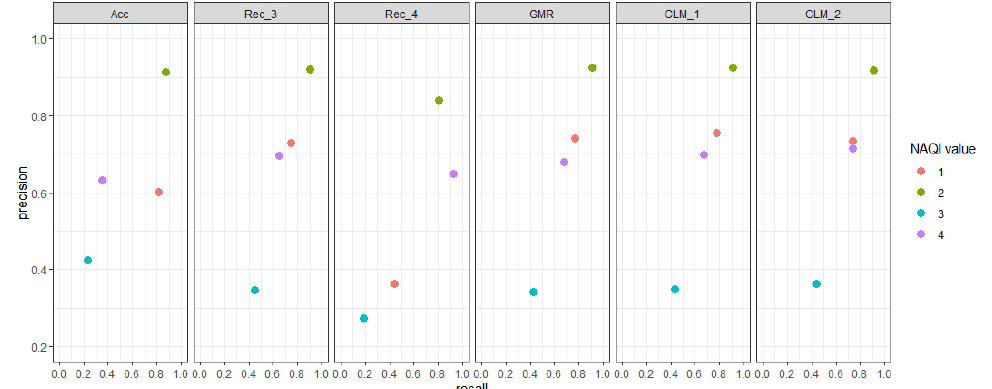
Figure 3. Results of precision–recall pairs for each class state and each optimized objective function (by